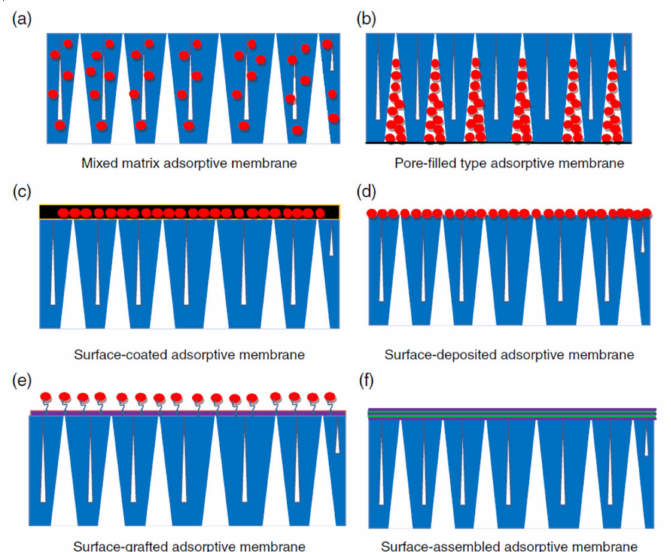
Figure 15. Composite membranes: ( a ) mixed; ( b ) pore-filled; ( c ) surface-coated; ( d ) surface-deposited; ( e ) surface-grafted; ( f ) surface-assembled (reprinted with permission from ref.